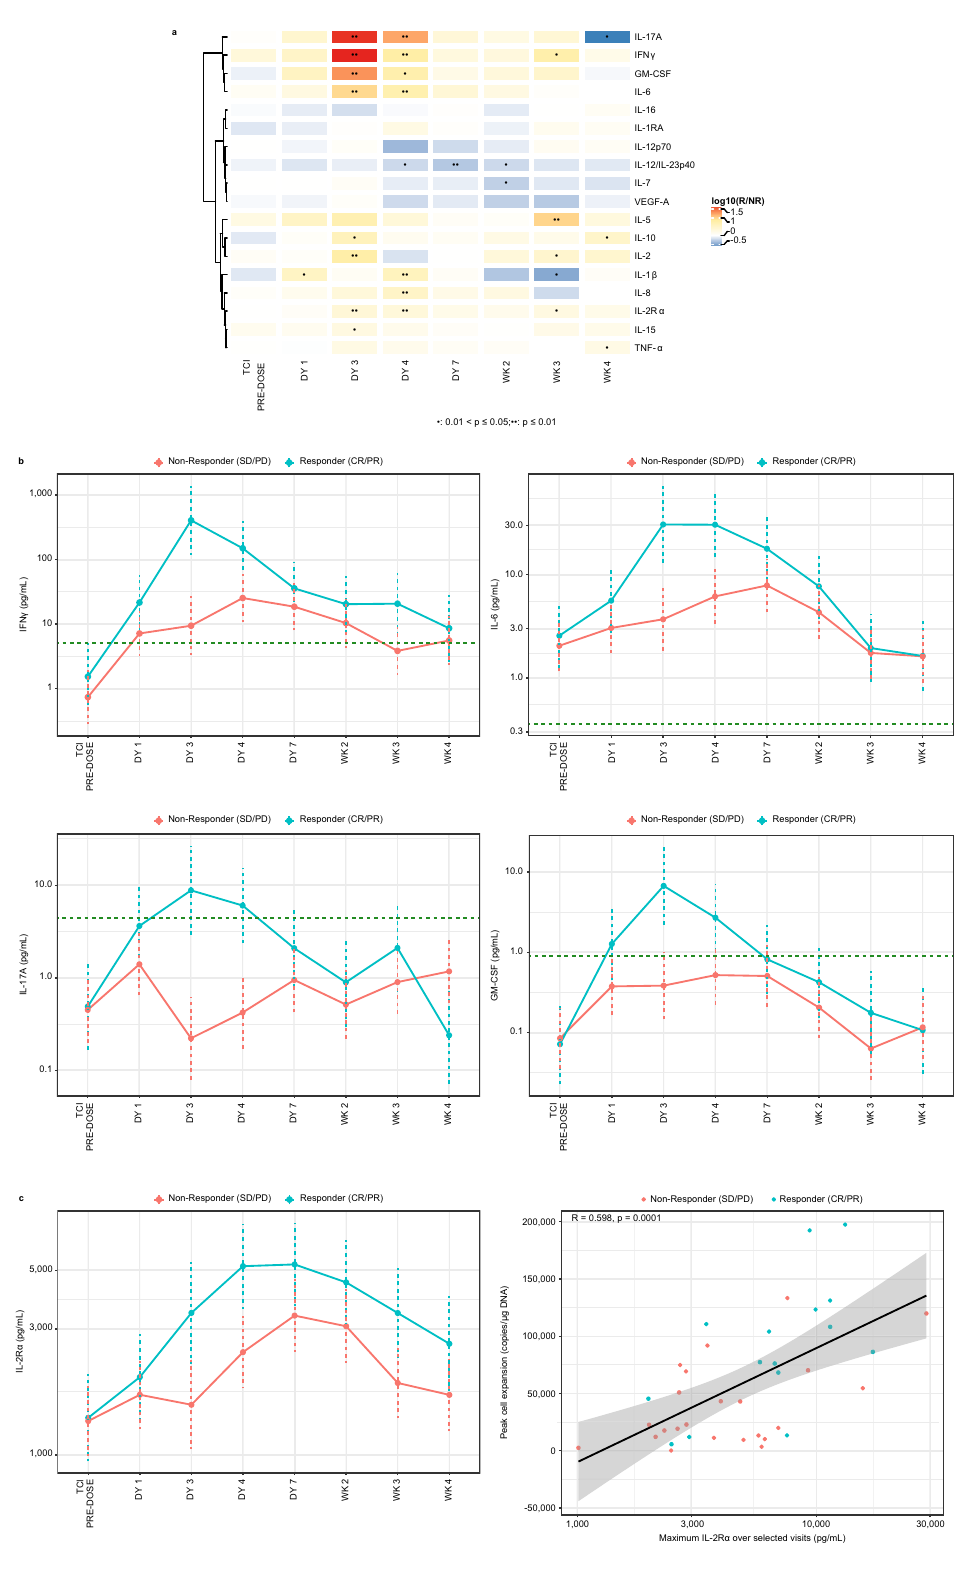
4:16). A totalof fi ve patients dropped out between leukapheresis and T cell infusion. Three patients dropped out due to death (one each from cohort 1, 2, 4), one patient withdrew consent (cohort 1), and one patient withdrew due to disease progression prior to treatment (cohort1).Themodi fi edITT(mITT)populationwas45patients(cohort 1: 12, cohort 2: 13, cohort 3: 5, cohort 4 :15). The mITT population